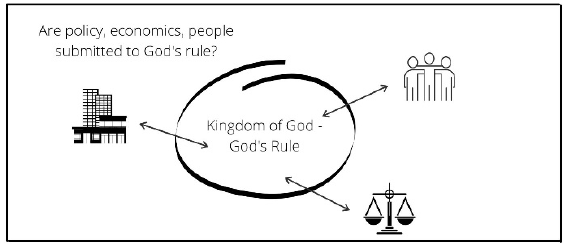
Figure 1. Reduced definition of kingdom of God as God’s rule.